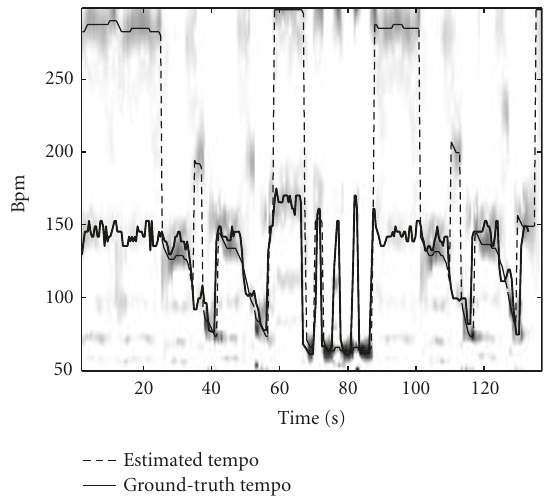
Figure 9: Tempo estimation over time: estimated tempo (dashed line), ground-truth tempo (continuous thick line) on [signal: Brahms “Ungarische Tanze